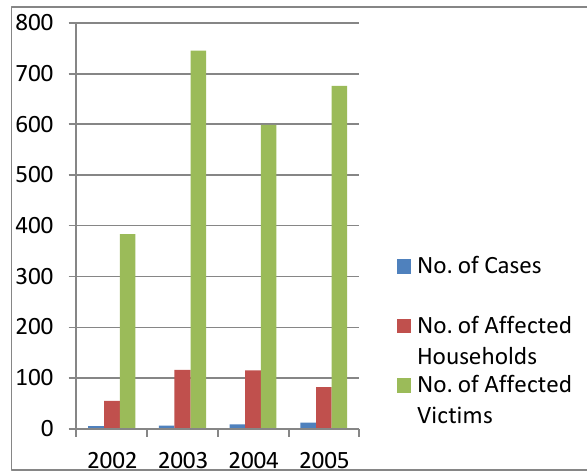
Fig. 2: Statistics on Bush Fire Disaster Records from 2002-2005 Source: NADMO - Krachi District, 2006